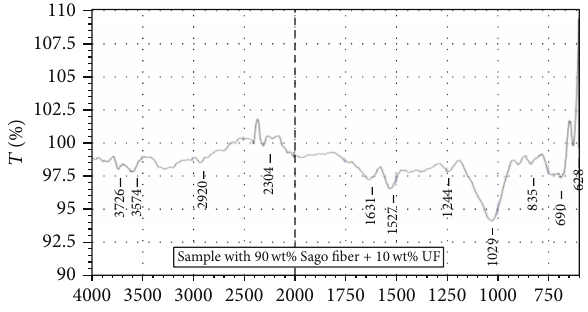
Figure 5: Sample C: Sago/UF Sample with particles size 2 mm. Figure 6: Sample D: Sago/UF Sample with 90 :10.